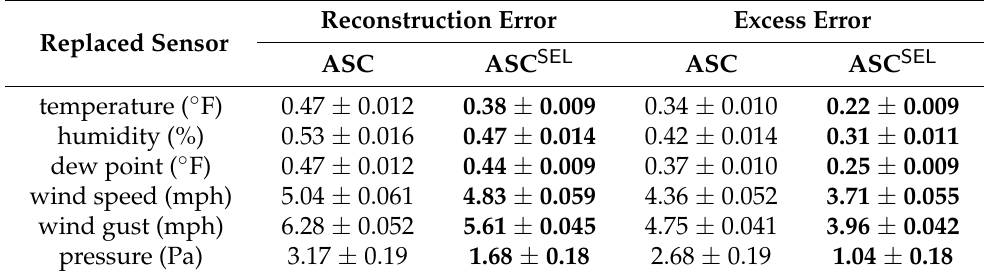
Table 6. Individual sensor changes on weather data with many sensors. Each entry shows the average reconstruction error and the corresponding standard error. The best performing method(s) (statistically significant up to one standard error) are in bold